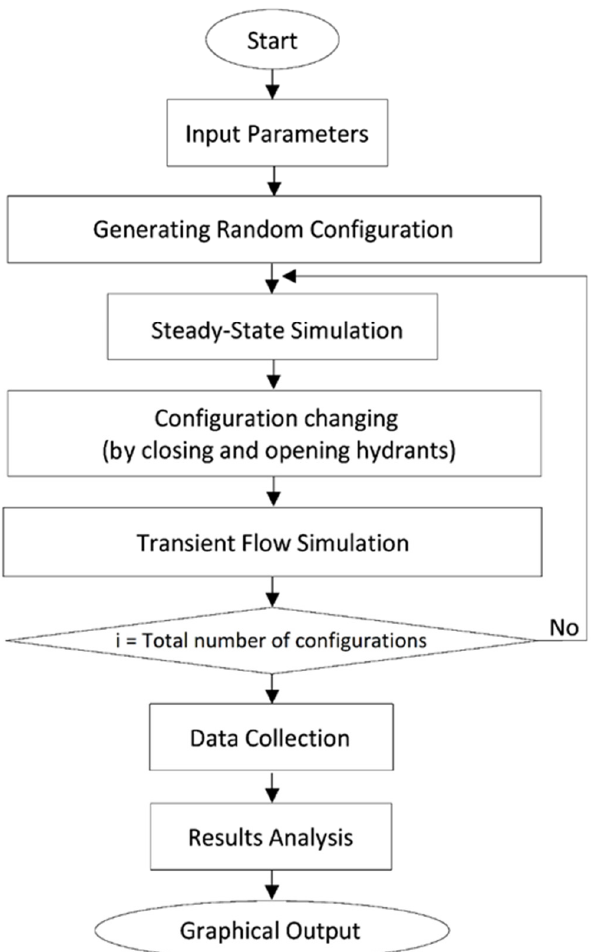
Figure 3. Computer code flowchart.